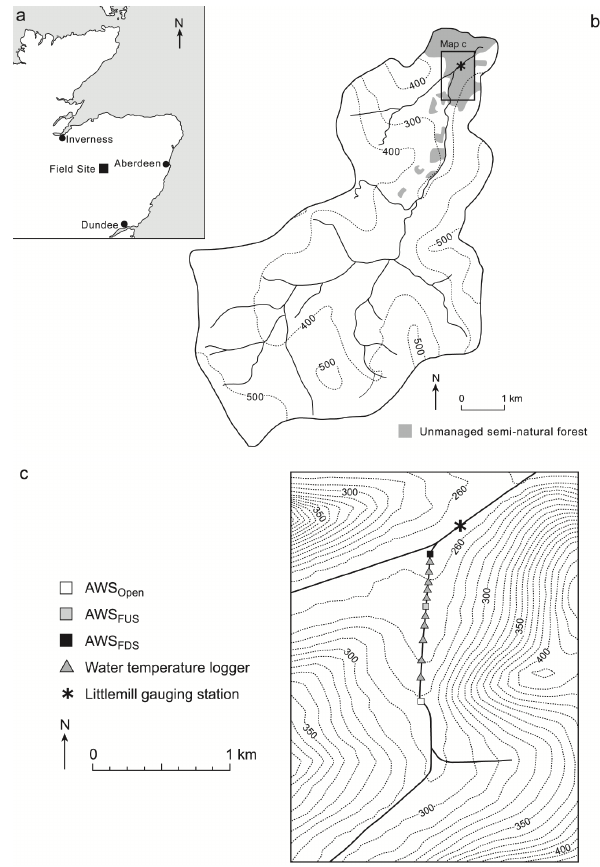
Figure 1. (a) Location map of the Girnock, (b) Girnock catchment and (c) locations of field data